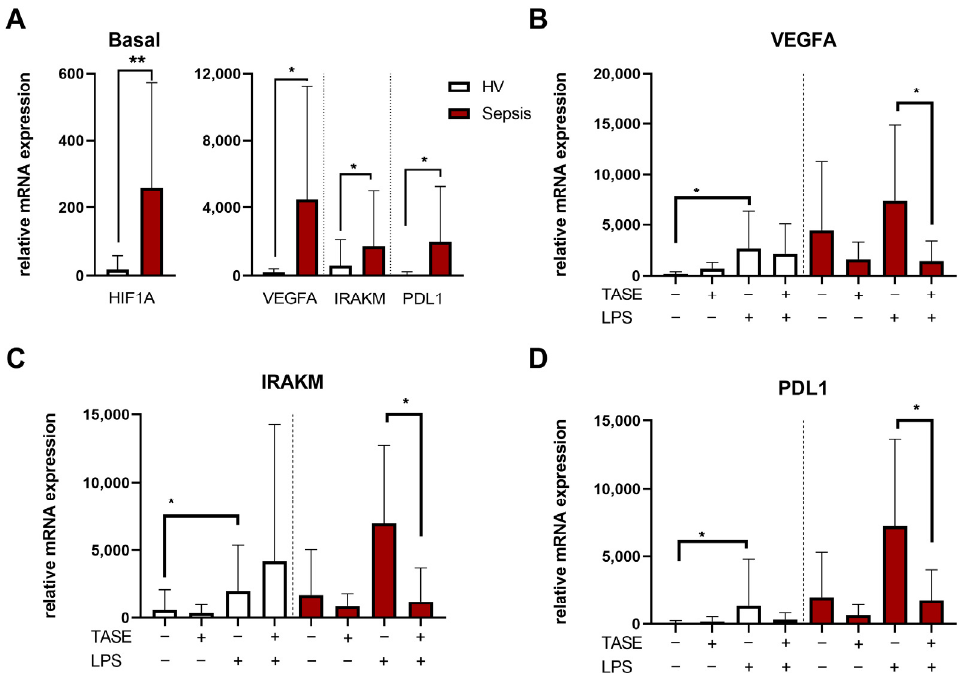
Figure 4. Expression of HIF-1 α and related genes in monocytes from HV and septic patients. ( A ) Basal expressions of HIF1A , VEGFA , IRAKM, and PDL1 in monocytes from HV ( n = 7) and septic patients ( n = 7) by RT-qPCR are shown. *, p < 0.05; ** p < 0.01 in Mann–Whitney t test. ( B – D ) Monocytes from HV and septic patients were stimulated with 10 ng/mL of LPS for 16 h in combination or not with 3 µ g/mL of TASE. Relative expressions of VEGFA ( B ), IRAKM ( C ), and PDL1 ( D ) are shown. *, p < 0.05 in paired t test. Bars represent mean ± SD.